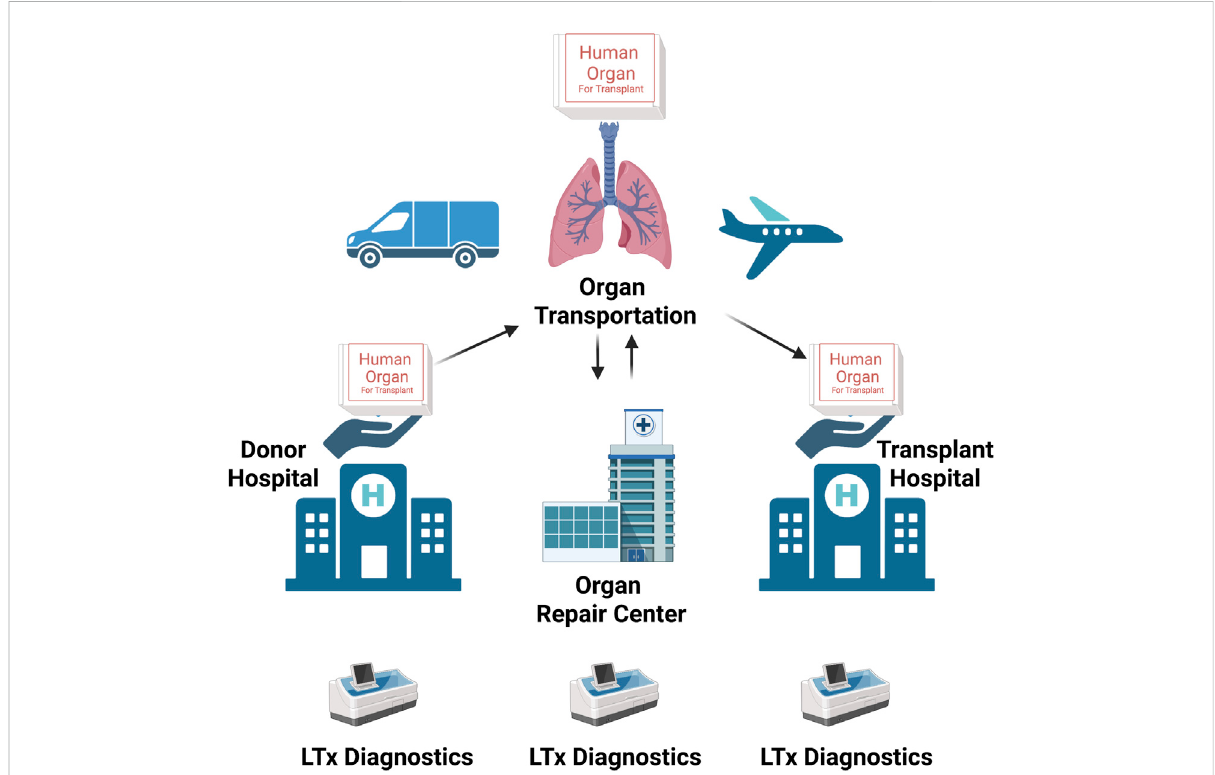
FIGURE 4 The schematic representation of the mode of operation of the modern “ organ-management ecosystem. ” Marginal organs are procured at the donor hospital and then transported and delivered to the “ Organ Repair Center. ” Here, they are subjected to tests to determine whether there is any margin to repair and regenerate them to become transplantable. Once an organ has been repaired and regenerated, it can be transported to the transplant center, where it will be transplanted (adapted from JTCVS Open) (176). Created with